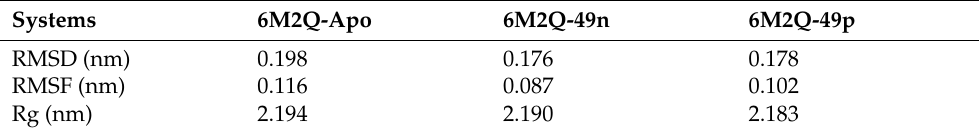
Table 8. ADMET properties for the designed compounds and the reference compound.